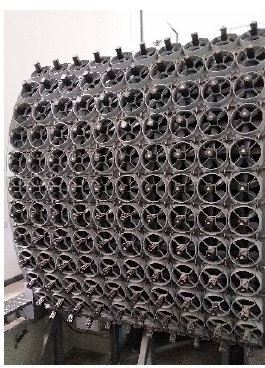
Figure 1. The multiple-fan active control wind tunnel (TJ-6) at Tongji University. The generated sinusoidal flow can be defined by u ( t ) = U + ∆ u · sin(2 π f u t ), the velocity oscillated in the along-wind (u-) direction. The time-averaged wind velocity was U = 8 m/s, and the Reynolds number based on the depth D was Re D = 16,080. The oscillation frequency ( f u ) and reduced amplitude ( ∆ u /U) were in the range of 0.2 ≤ f u ≤ 1.2 Hz and 0 ≤ ∆ u /U ≤ 0.25, respectively. In the remainder of this paper, the sinusoidal flow configuration with the frequency α and amplitude β will be referred to SF ( α , β ). For the purpose of comparisons, the smooth flow cases were also generated, which can be regarded as f u = 0 and ∆ u /U = .